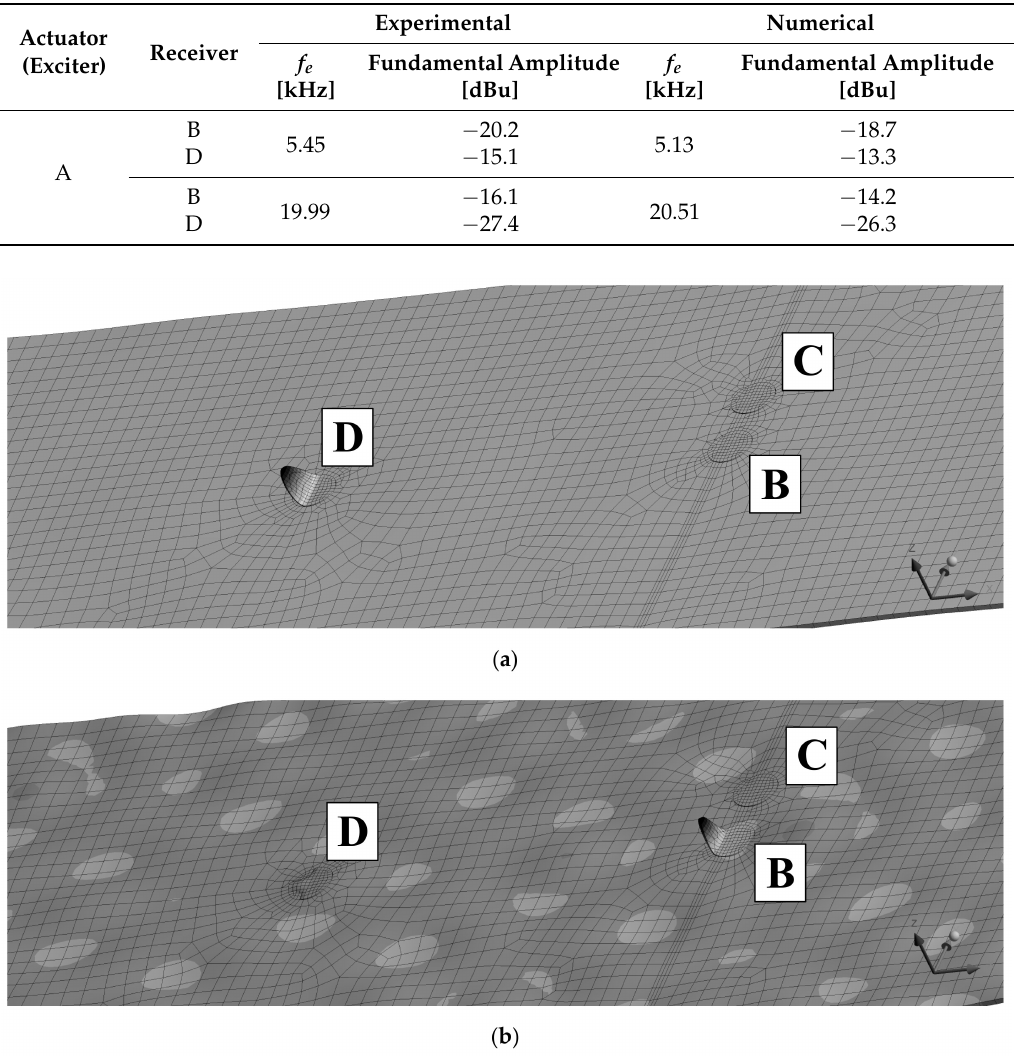
Figure 9. FE simulation of harmonic excitation at 5.13 kHz ( a ) and 20.51 kHz ( b